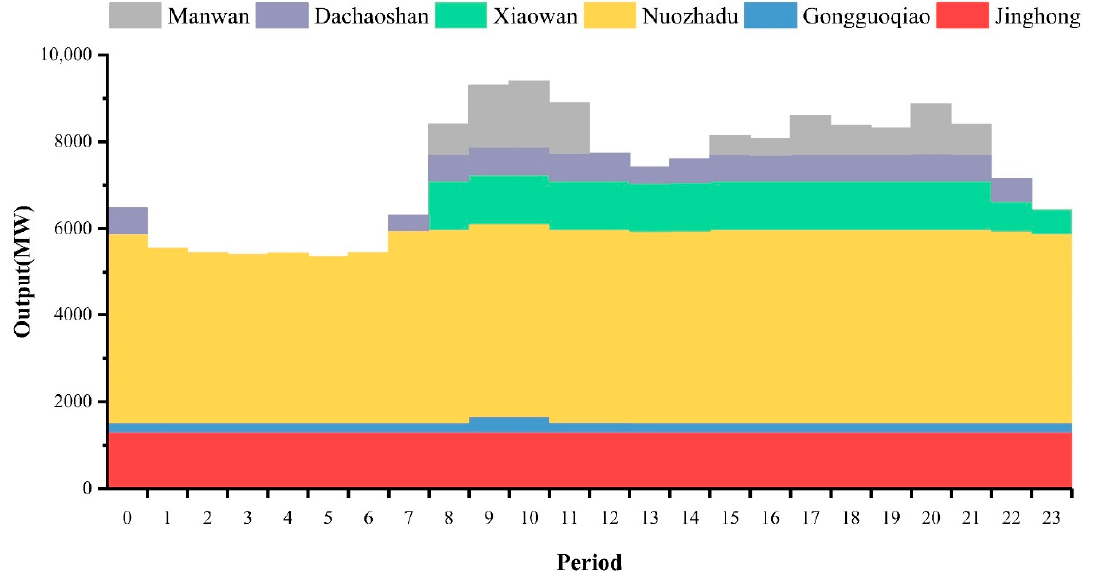
Figure 6. Hourly power generations of plants (chronologically).